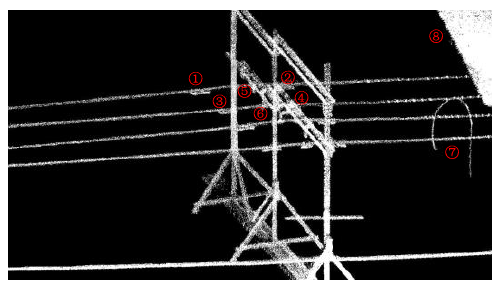
Figure 17. The original point cloud of the test site.